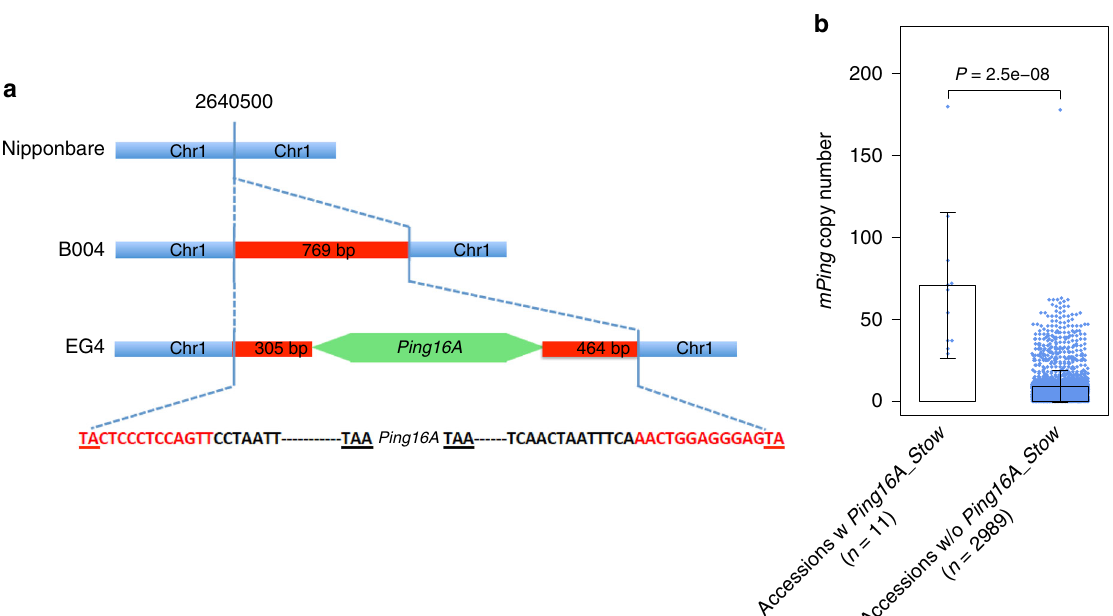
Fig. 4 Structure of the Ping16A_Stow locus, which is associated with increased mPing copy number. a Structure of the Ping16A_Stow insertion site. The Ping16A element (green arrow) is inserted in the middle of a nonautonomous Stowaway element (red box), which is not in Nipponbare (blue bar). Nucleotides shown within the blue dotted lines are the sequences of the nonautonomous Stowaway element. Target site duplications (TSDs) are indicated by nucleotides underscored. b Comparisons of mPing copy number in 3000 rice accessions with or without Ping16A_Stow in the genome. Gray dots indicate mPing copy number of rice accessions in each category. The error bars show standard deviation (s.d.) of each category. Differences in mPing copy numbers between two categories were tested by a two-tailed Wilcoxon – Mann – Whitney test. Source data for Fig. 4b are provided in Supplementary Data